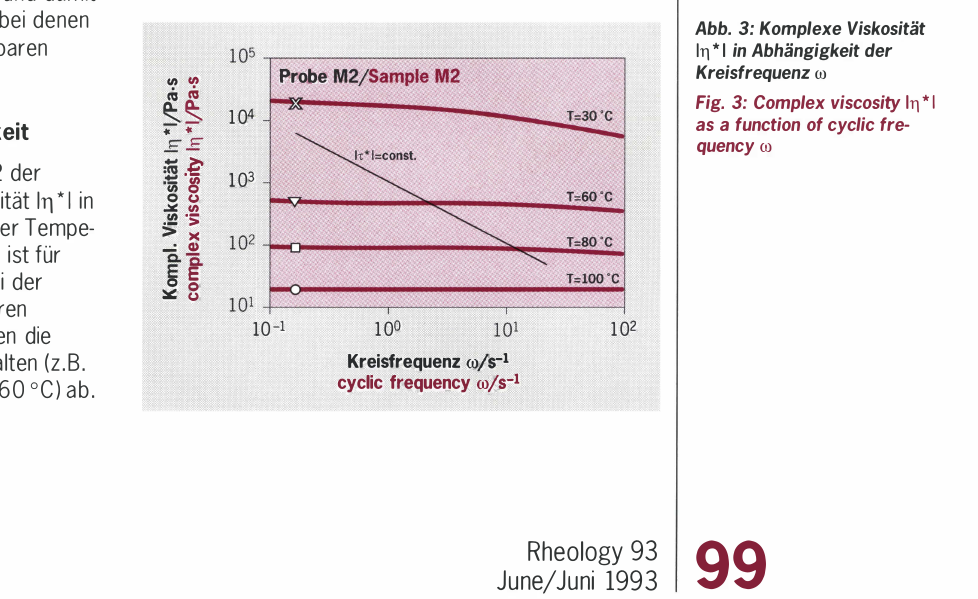
Abb. 3: Komplexe Viskositiit 111 * I in Abhiingigkeit der Fig. 3: Complex viscosity 111 * I as a function of cyclic fre­ quency